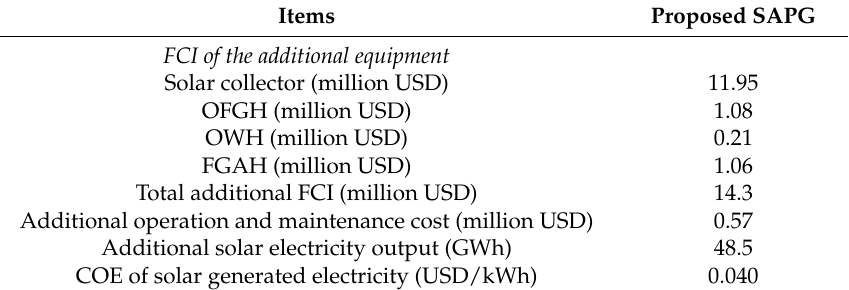
Table 10. Economic performances of the proposed